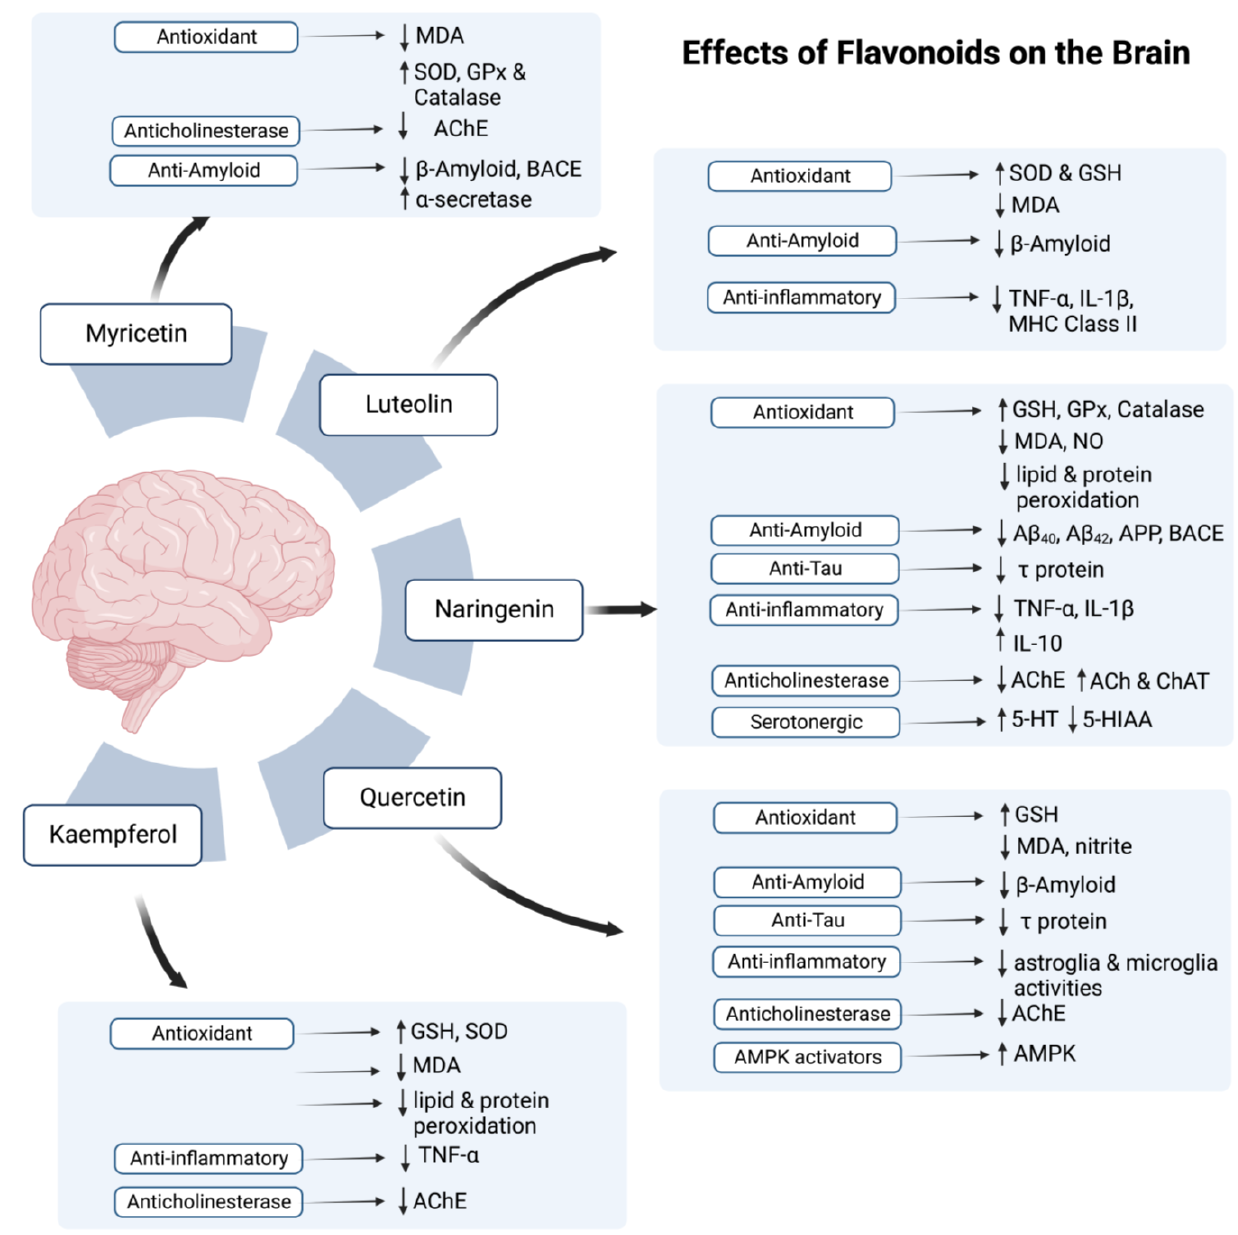
Figure 2. The possible effects of flavonoids in honey on the brain. Symbol ( ↑ ) represents increase while ( ↓ ) represents decrease.